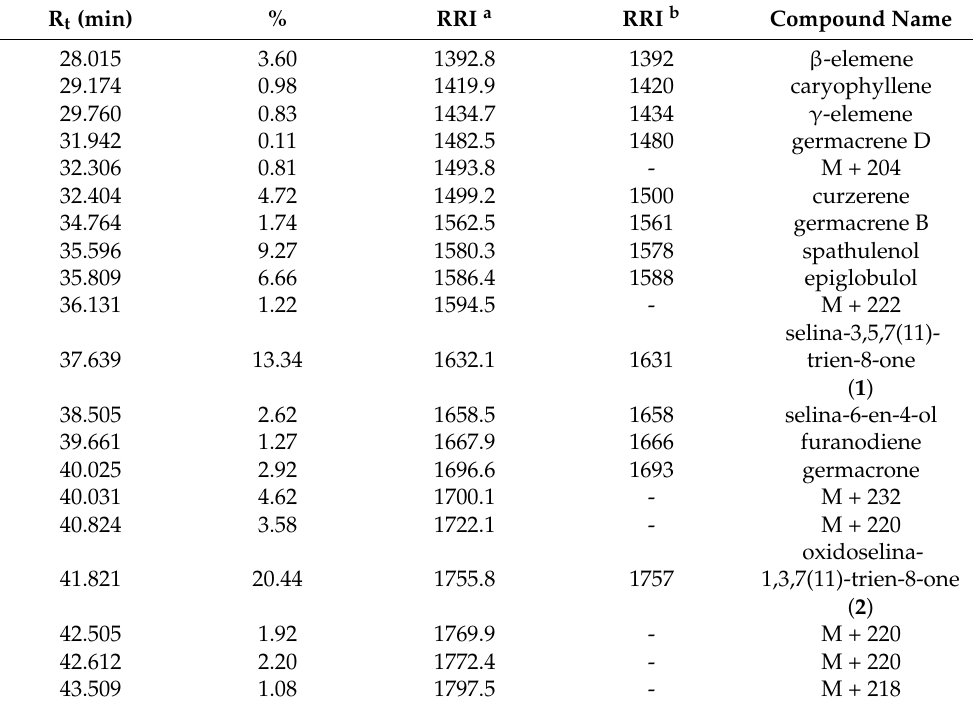
Table 1. Relative composition (%) of the identified components in the GC–MS analysis of the essential oil from leaves of E. uniflora . R t (min) % RRI a RRI b Compound